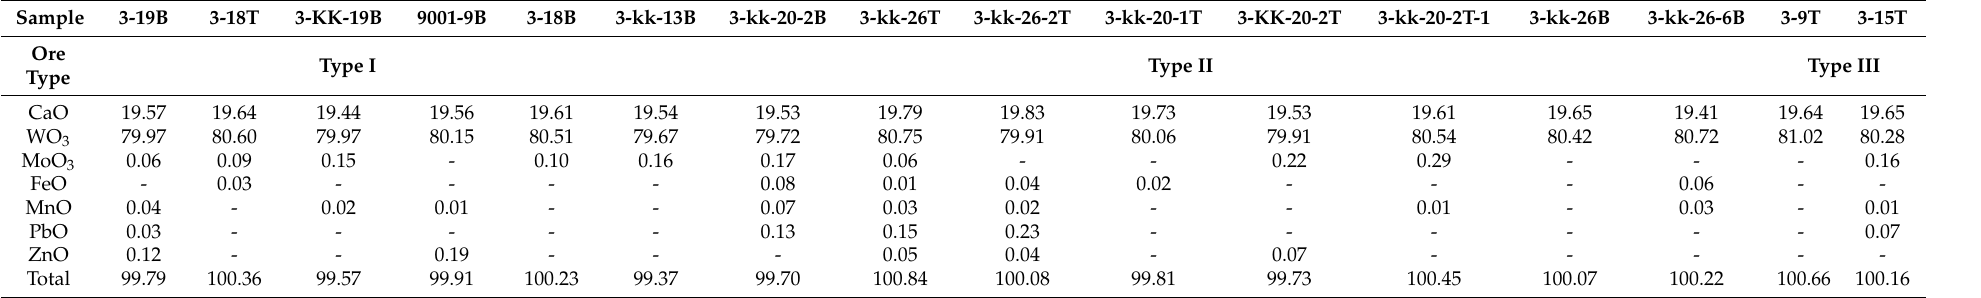
Table 1. Contents of major oxides of scheelite samples from the Doranasai gold deposit (wt%).